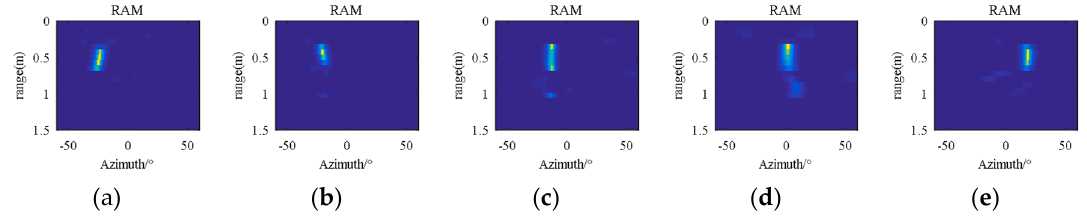
Figure 13. RAMs of a sliding left to right hand gesture. ( a ) RAM of frame 1. ( b ) RAM of frame 6. ( c ) RAM of frame 11. ( d ) RAM of frame 20. ( e ) RAM of frame 30.